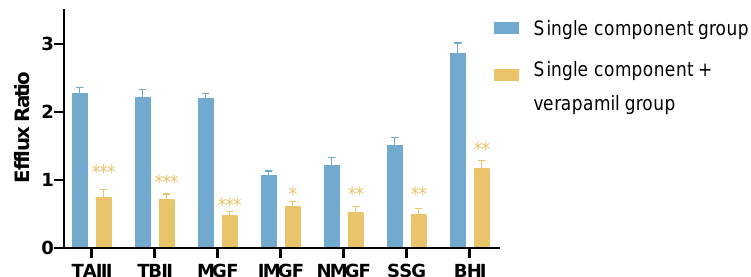
Figure 2. Effect of verapamil on the efflux ratio of timosaponin A III (TAIII), timosaponin B II (TBII), mangiferin (MGF), neomangiferin (NMGF), isomangiferin (IMGF), sarsasapogenin (SSG), and baohuoside I (BHI). Data are expressed as mean ± SD (n = 3). * p < 0.05, ** p < 0.01, *** p < 0.001 compared to single component group.